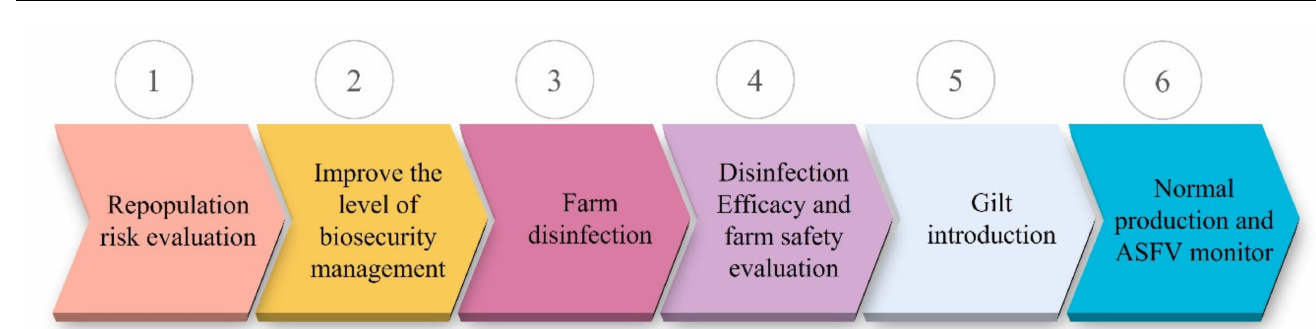
Figure 4. The flow chart for pig farm repopulation. At first, a repopulation risk evaluation should be conducted. Then, relevant facilities are established or renovated to improve the level of biosecurity management. After that, the farm is cleaned and disinfected thoroughly and the disinfection efficacy and farm safety are assessed by laboratory disinfection tests and/or sentinel animal evaluations before gilts introduction. Finally, normal production is carried out and ASFV infections are monitored